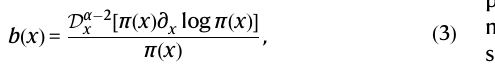
featuring asynchronous activity ( ξ =4.25, 15ms time window) and a localized pro- pagating wave ( ξ =2.55, 2ms time window), respectively. Red curve indicates the CoM trajectory of the propagating wave. d When adaptation is removed, the his- togram of the sample increments (solid line) still exhibits a power-law tail (dashed line). e Samplepathautocorrelationshowstheabsenceofanticorrelationasaresult ofremovingneuraladaptation. f Meansquarederrorofthesamplemeandecreases slowly with the time lag, with a baseline due to quenched noise (randomness in synaptic